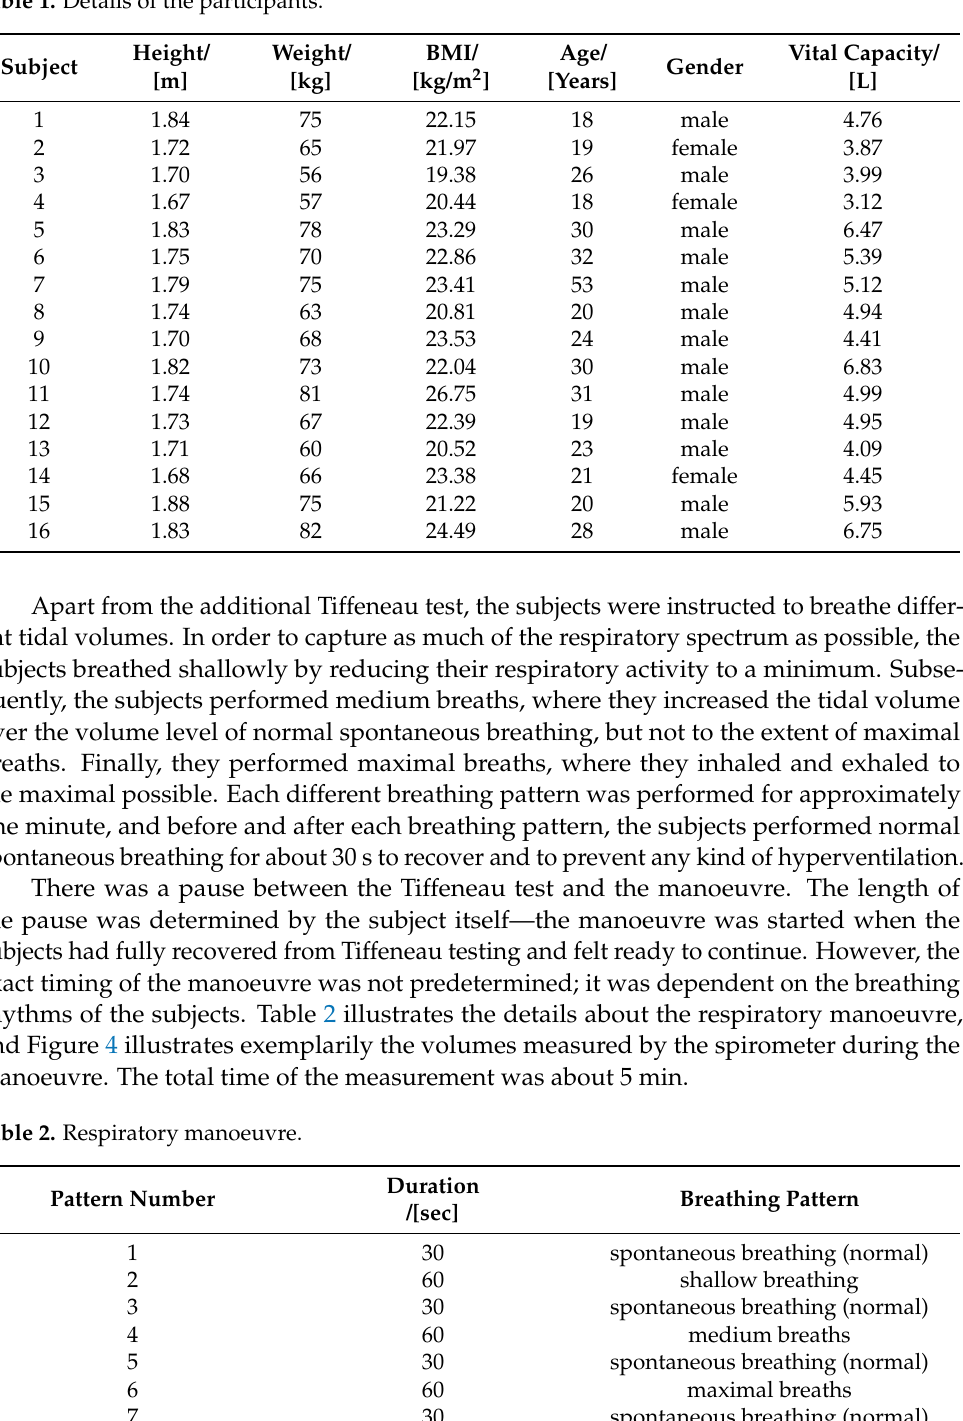
Table 1. Details of the participants.